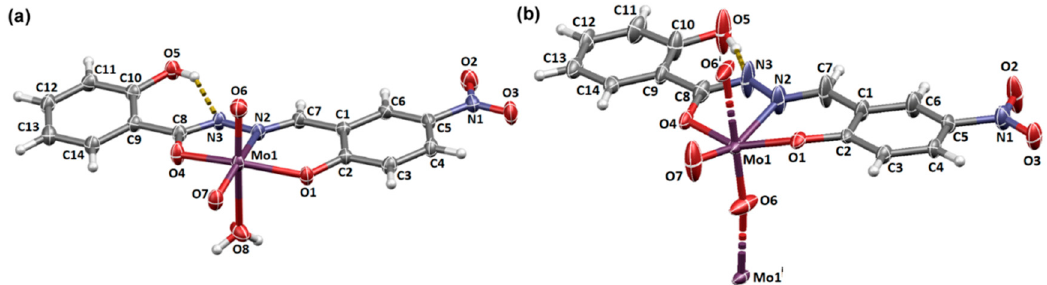
Figure 1. Molecular structures with the atom-labeling scheme of: ( a ) [MoO 2 (L 1 )(H 2 O)]; and ( b ) the repeating unit in [MoO2(L 1 )] n . The displacement ellipsoids are drawn at a 50% probability level for ( a ) and at a 30% probability level for ( b ) at 170 K. Hydrogen atoms are presented as spheres of arbitrary, small radii. The intramolecular hydrogen bonds of the O–H ∙∙∙ N type are highlighted as yellow dashed lines. In ( b ), the symmetry code i = 1/2+ x , y ,3/2- z .